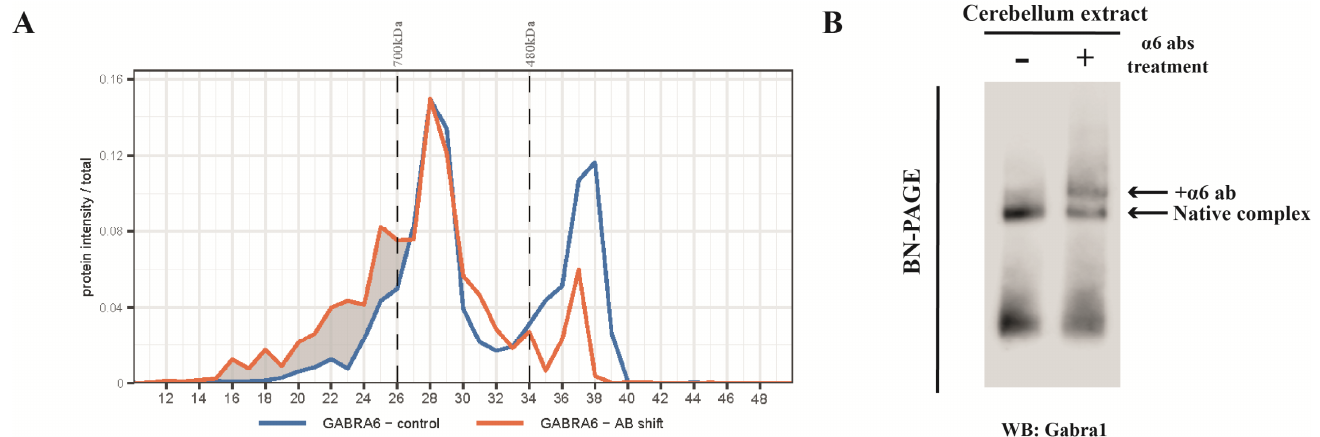
Figure 2. Migration of GABA A R α 1 subunit after anti- α 6 antibody shift identified by mass spectrometry and immunoblotting. ( A ) The comparison of protein profiles of the α 1 subunit between control and anti- α 6 subunit antibody shift groups. Markers for 480 and 700 kDa were indicated on the top of panel and gel slice number is presented on the x -axis of the panels. ( B ) BN-PAGE of anti-Gabra6 antibody shifted cerebellum lysate and control lysate were transferred on PVDF membrane and immunostained for Gabra1. The α 1 subunit was identified in the control group and antibody shifted group as indicated.